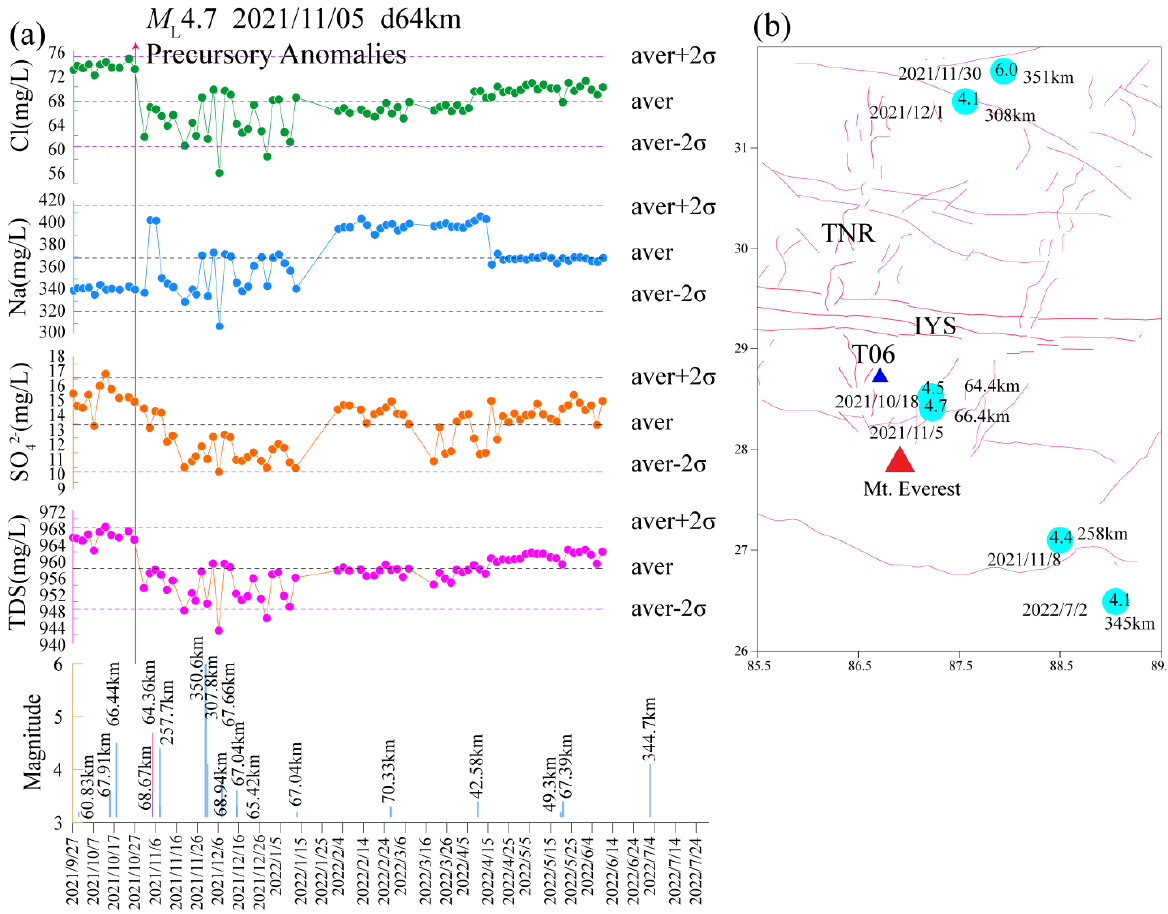
Figure 8. ( a ) The temporal variations in Na + , Cl − , SO 4 2− , TDS, and earthquakes; ( b ) the distribution plot of sampling T06 and earthquakes within 400 km and magnitude range over M L ≥ 4.0.